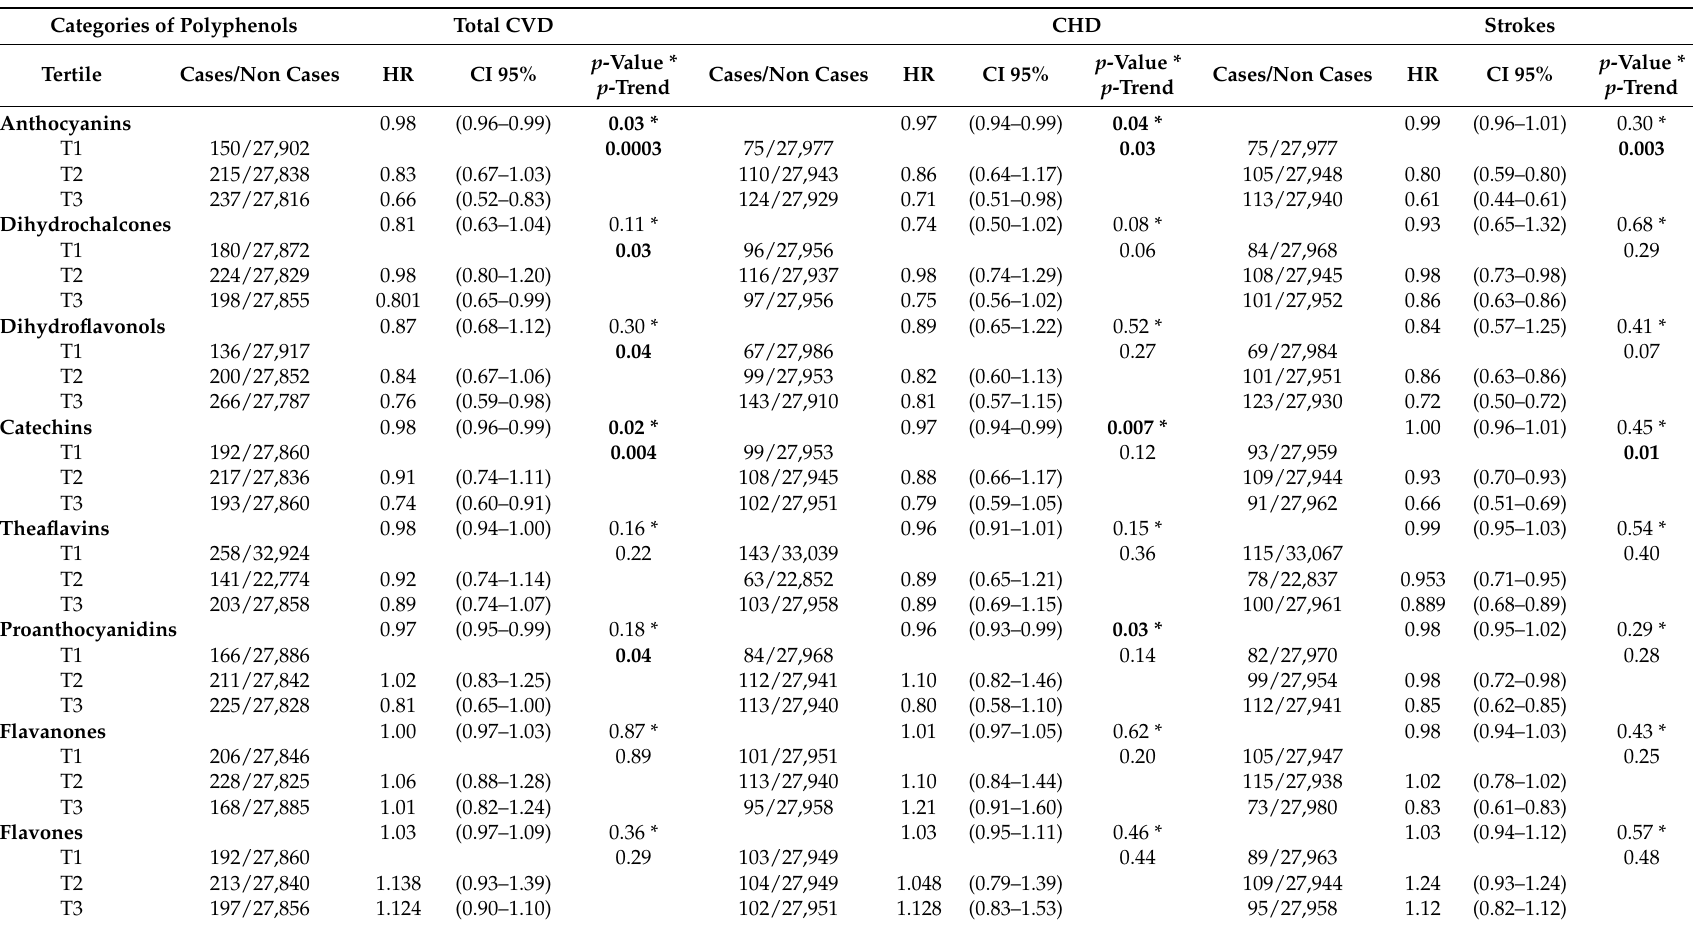
Table 3. Multivariable 1 associations (hazard ratios (HR) and 95% confidence intervals (95% CI)) between continuous or sex-specific tertiles 2 of polyphenol intakes and cardiovascular disease risk (total, CHD, and stroke), NutriNet-Sant é Cohort, France,